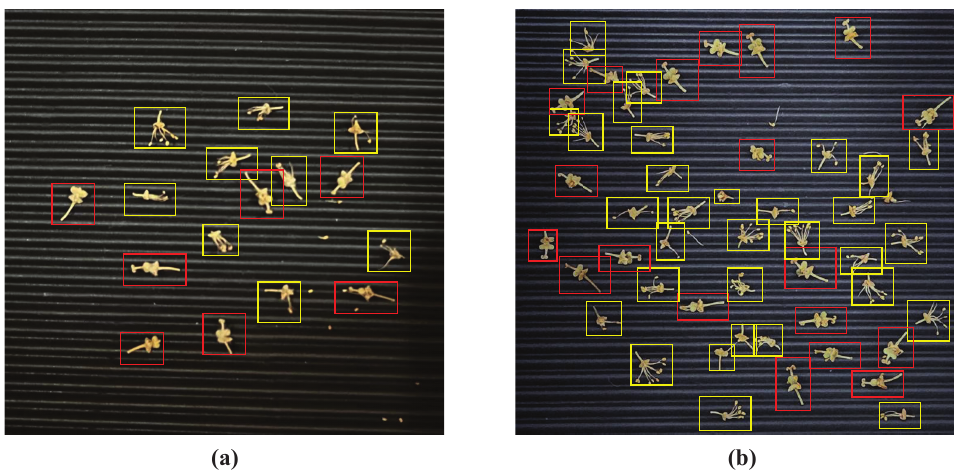
Figure 1. Litchi flower spike sleeve with dried flower sample.